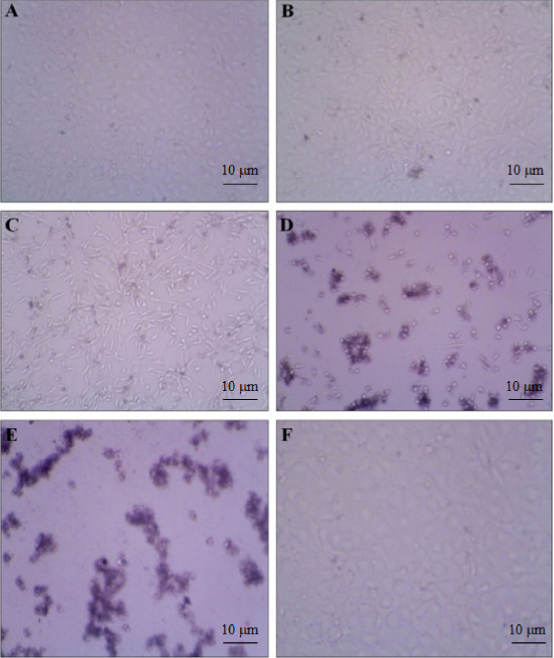
Figure 8. DMSO-treated control cells showed the density of the cells. ( A ) 18.75; ( B ) 37.50; ( C ) 75; ( D ) 150; and ( E ) 300 µ g/mL treatment showed gradual cell toxicity compared to control. ( F ) Methanol low dose treatment. Scale bars.10 µ